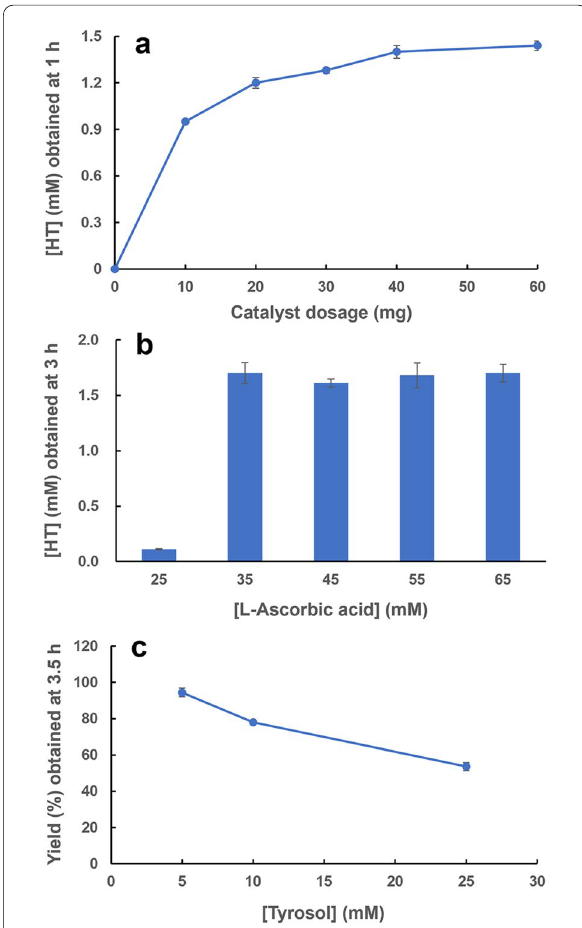
Fig. 6 Production of hydroxytyrosol (HT) from tyrosol catalyzed by tyrosinase@HKUST‑1 (II): effect of catalyst dosage ( a ), l ‑ascorbic acid concentration ( b ), and initial tyrosol concentration ( c ) on the formation of HT